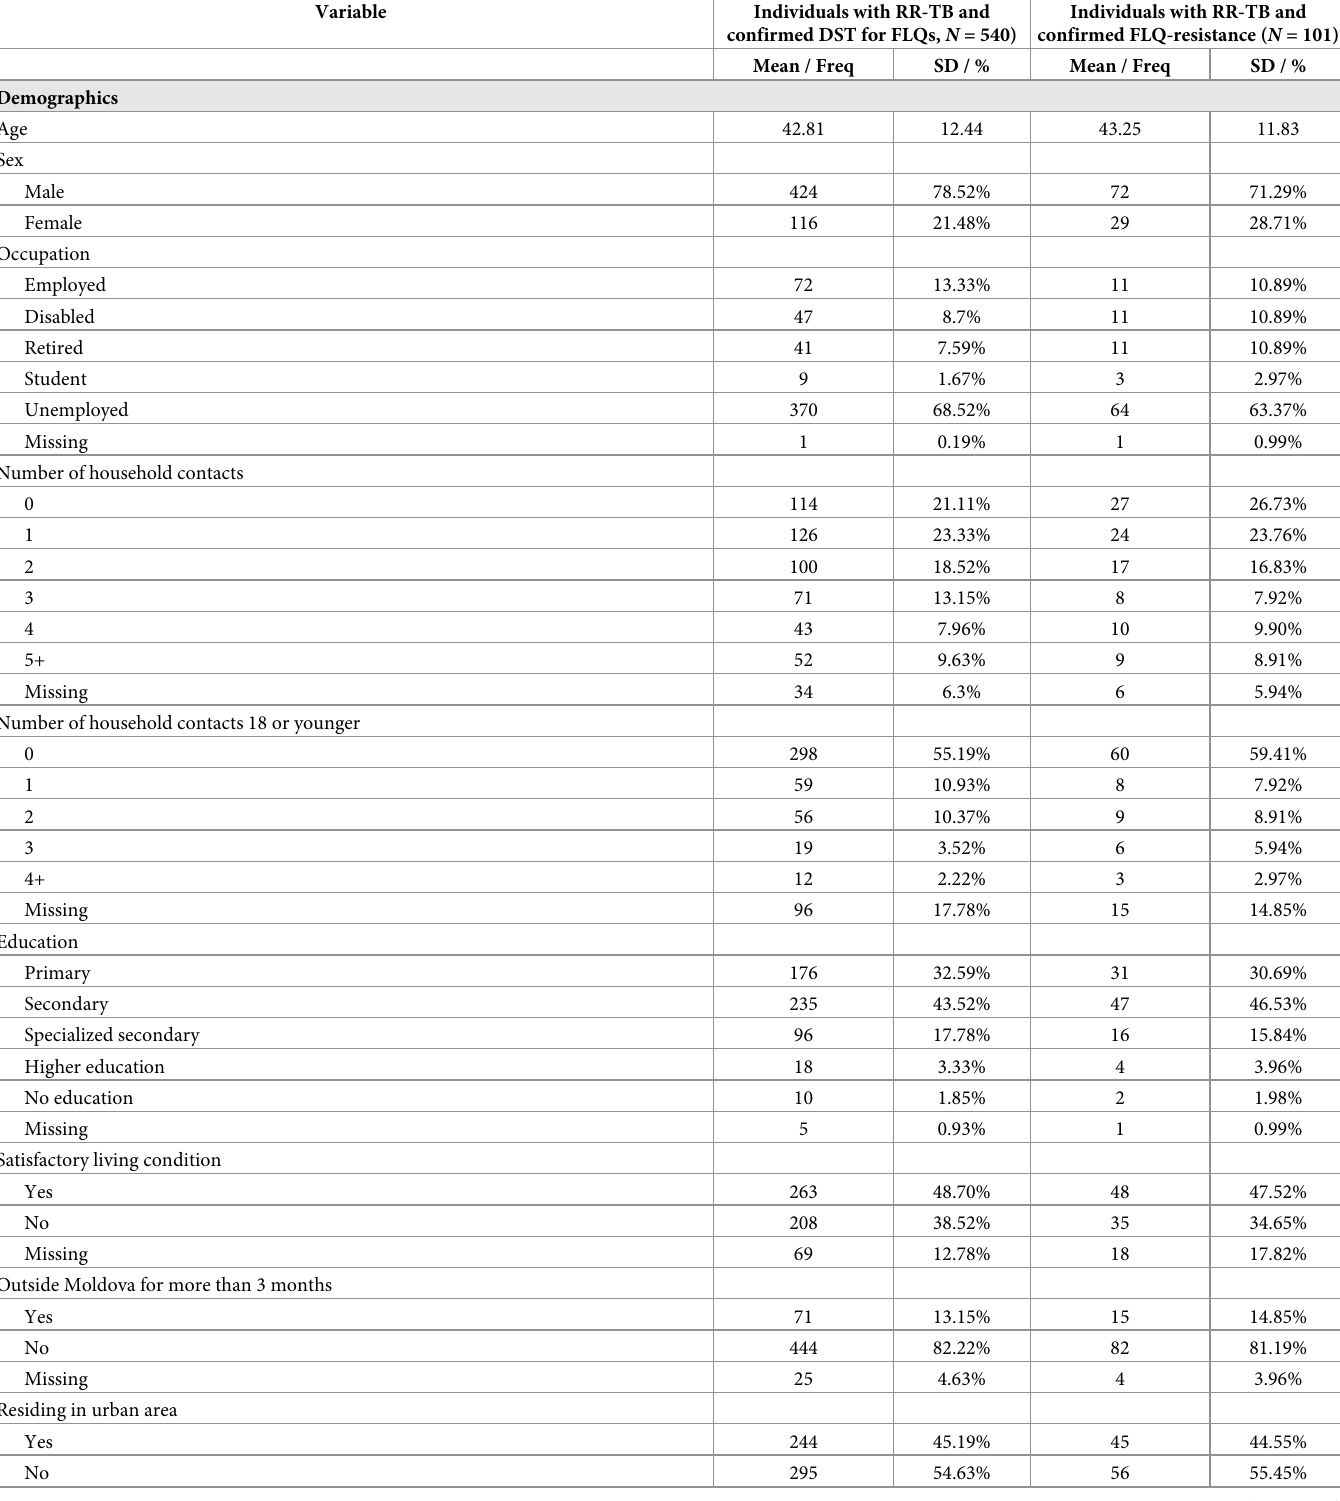
Table 1. Demographic information, TB-related information, and test results in the data collected from the national tuberculosis surveillance system in the Republic of Moldova between January 2018 to December